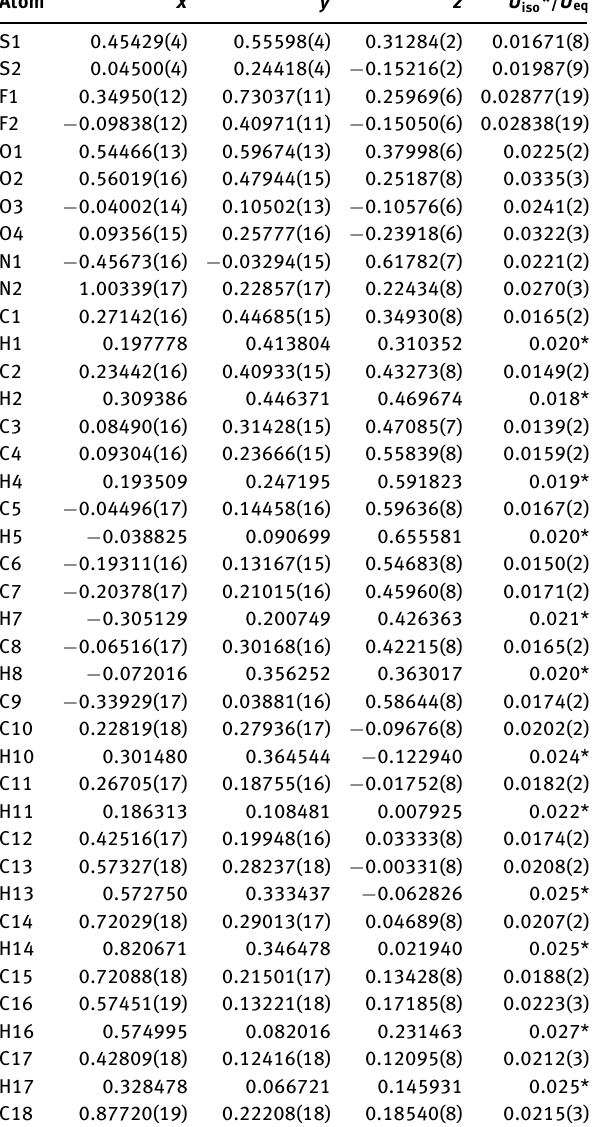
Table 2: Fractional atomic coordinates and isotropic or equivalent isotropic displacement parameters (Å 2